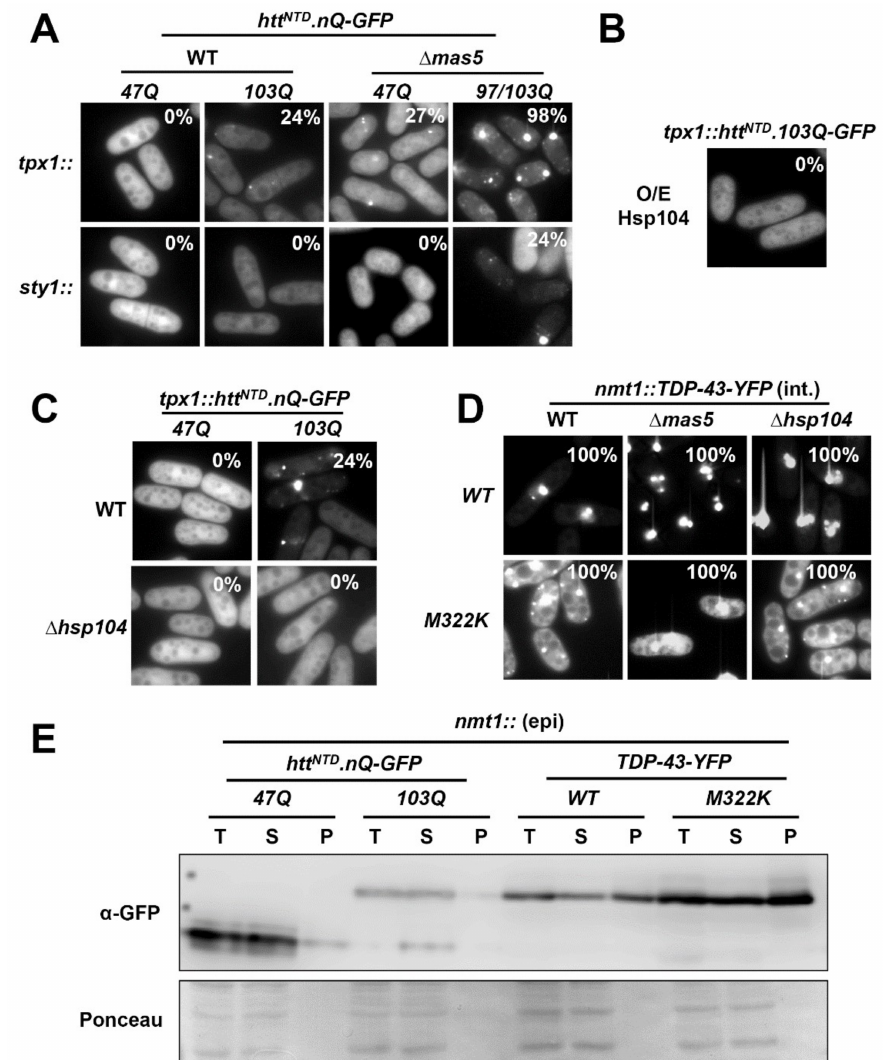
Figure 4. Components of the PQC system are involved in Htt NTD .nQ-GFP, but not TDP-43-YFP, aggregation. ( A ) Fluorescence microscopy of wild-type and ∆ mas5 strains expressing Htt NTD .nQ- GFP under the control of constitutive tpx1 (WT: AB1.47Q and AB1.103Q; ∆ mas5 : SB413.47Q and SB413.103Q) or sty1 promoter (WT: LM30.47Q and LM30.103Q; ∆ mas5 : LM18.47Q and LM18.103Q). The percentage of cells with aggregates is indicated. N = 55 for tpx1 -driven 103Q constructs in WT cells; N = 100 and 80 for tpx1 -driven 47Q and 103Q constructs in ∆ mas5 cells; N = 70 in sty1 -driven 97/103Q in ∆ mas5 cells. ( B ) Fluorescence microscopy of cells expressing tpx1 -driven HttNTD.103Q-GFP (AB6.103Q) transformed with p520 to over-express Hsp104 under the control of the episomal nmt41 promoter. ( C ) Fluorescence microscopy of wild-type and ∆ hsp104 strains expressing Htt NTD .nQ-GFP under the control of constitutive tpx1 promoter (WT: AB1.47Q and AB1.103Q; ∆ hsp104 : AB2.47Q and AB2.103Q). The percentage of cells with aggregates is indicated. N = 52 for 103Q construct in WT cells. ( D ) Fluorescence microscopy of wild-type, ∆ mas5 and ∆ hsp104 strains expressing TDP-43-YFP under the control of the conditional integrative nmt1 promoter [WT: LM218 (WT), LM218.M322K ( M322K ); ∆ mas5 : LM225 ( WT ) and LM225.M322K ( M322K ); ∆ hsp104 : LM219 (WT) and LM219.M322K ( M322K )]. The percentage of cells with aggregates is indicated. N = 50 for all constructs. ( E ) Solubility TDP-43-YFP under the episomal nmt1 promoter [HM123 transformed with p659.47Q.3x ( 47Q ) and p659.103Q.3x ( 103Q ) or with p660.3x ( WT ) and p660.M322K.3x (M322K)] grown in MM. Protein levels as loading